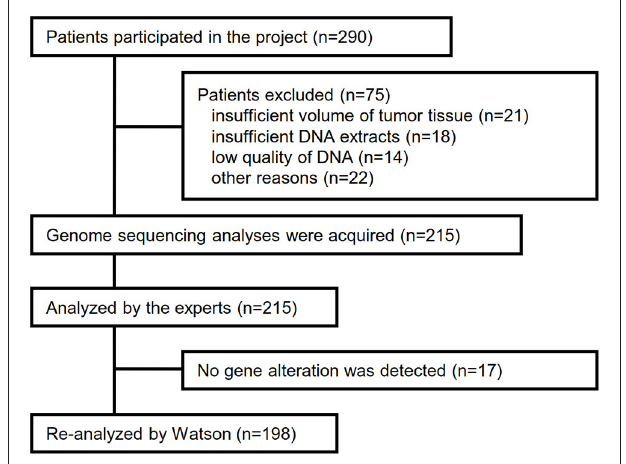
FIGURE 1 | Flow diagram for selection of cancer patients in this